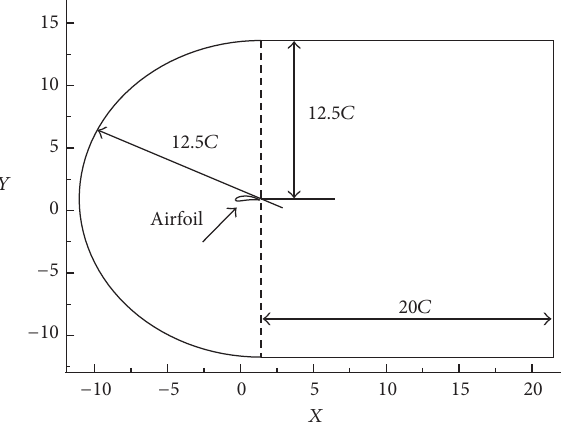
Figure 6: Computational